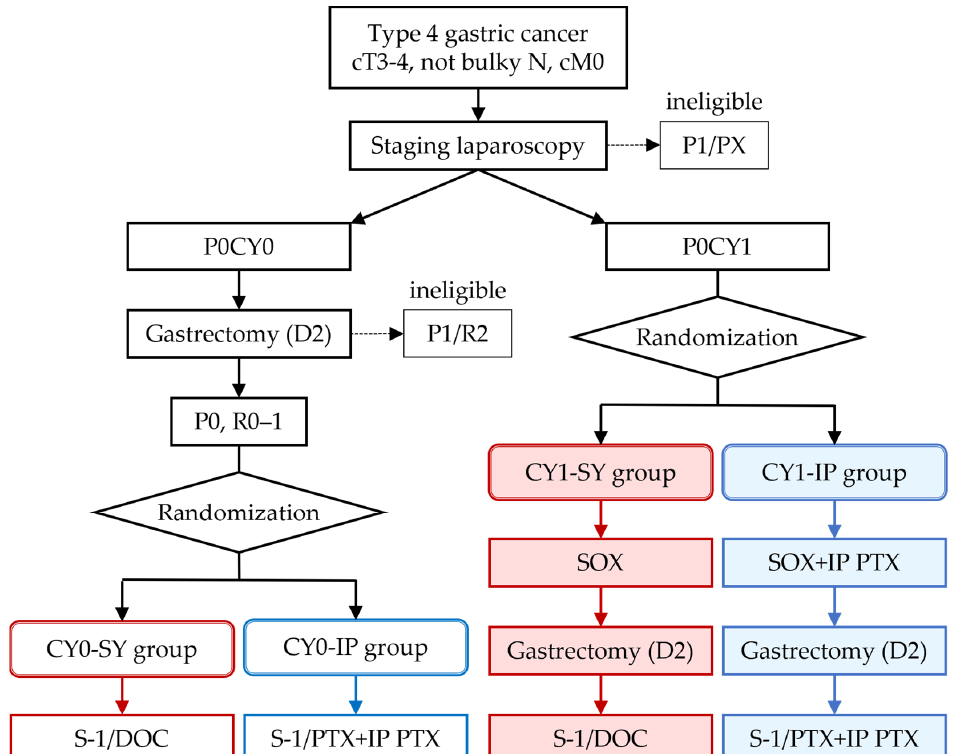
Figure 1. Flow of the study. P0, no peritoneal metastasis; P1, peritoneal metastasis; PX, peritoneal metastasis is unknown; CY0, peritoneal cytology negative for carcinoma cells; CY1, peritoneal cytology positive for carcinoma cells; R0, no residual tumor after surgery; R1, microscopic residual tumor (positive resection margin or CY1); R2, macroscopic residual tumor; SY group, systemic chemotherapy group; IP group, combined IP and systemic chemotherapy group. The red boxes and the blue boxes represent the group names and the treatments of the systemic chemotherapy groups and the combined IP and systemic chemotherapy groups, respectively.